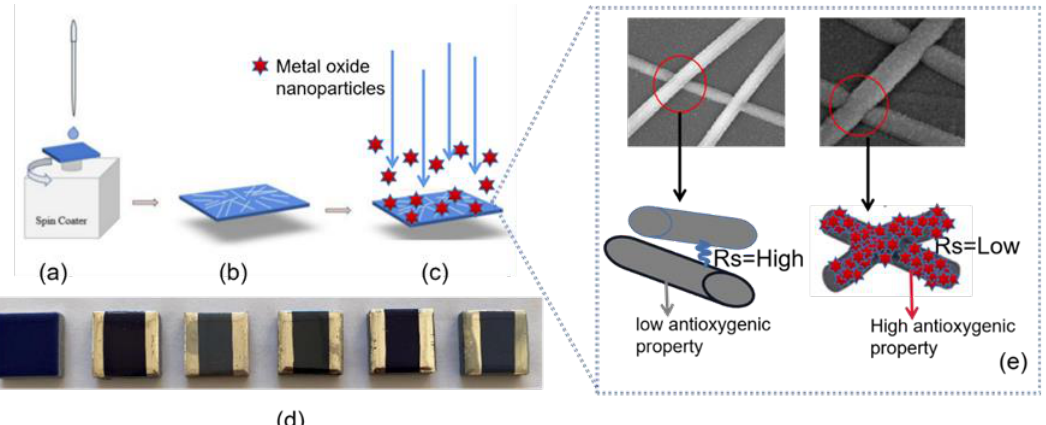
Figure 1. Schematics illustrating the MONPs modify of AgNWs network by magnetron sputtering method and its positive impact on AgNW-TCF. ( a ) The fabrication of AgNWs-TCFs by spin coating. ( b ) AgNWs-TCFs. ( c ) The MONPs modify the AgNW network by magnetron sputtering method. ( d ) The ceramic substrate and AgNWs@ MONPs-TCFs samples, from left to right, are ceramic substrate, AgNWs-TCF, AgNWs@SnO 2 -TCF, AgNWs@Al 2 O 3 -TCF, AgNWs@TiO 2 -TCF and AgNWs@ZnO-TCF, respectively. ( e ) Carrier transport across the wire − wire junction and the layer wrap on AgNW in AgNWs-TCFs before (left) and after (right) modified by